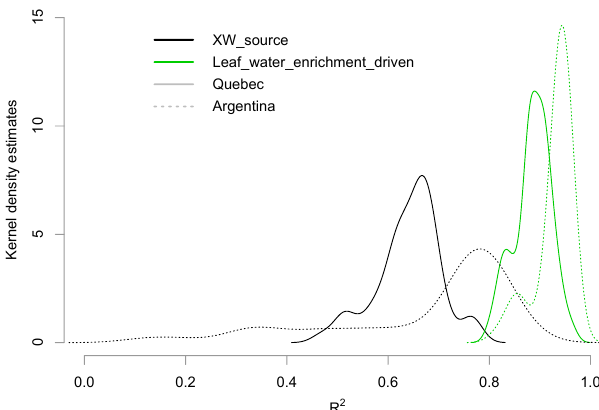
Figure 5. Density distributions of the coefficients of determination ( R 2 ) between the reference simulations and the (1) XW source ex- periment simulation ( δ 18 O V and h air set as constant, black) and (2) leaf water enrichment-driven experiment simulation ( δ 18 O XW set as constant, green) in Québec (bold line) and Argentina (dashed